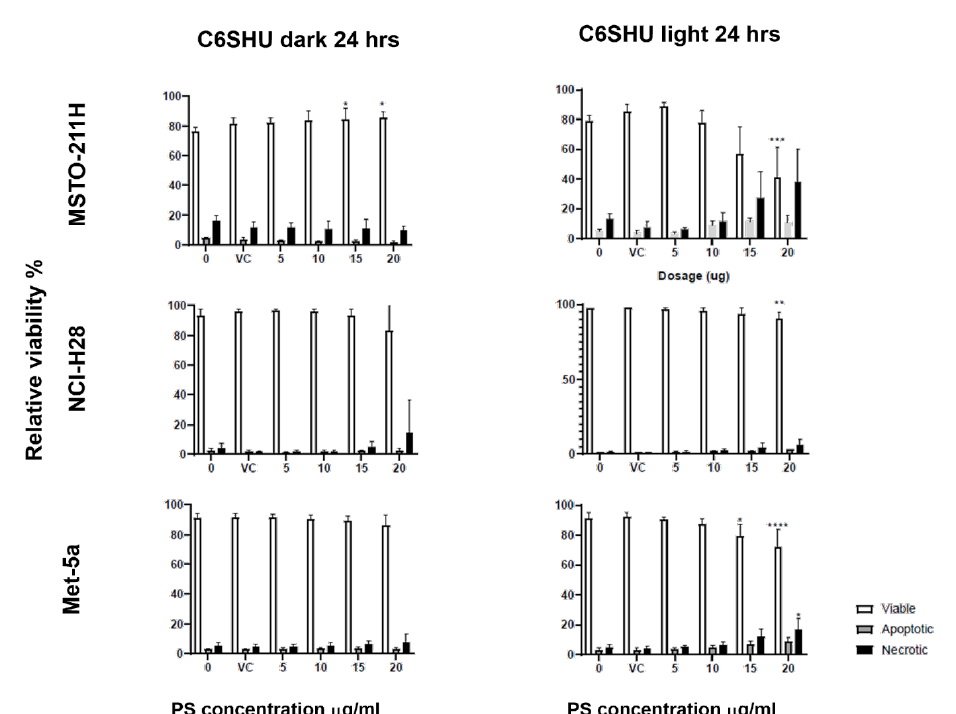
Figure 9. Cell death analysis of C6SHU-treated MSTO-211H, NCI-H28, and Met-5a cells as deter- mined by the Annexin V-FITC/PI assay 24 h after treatment. Results are expressed as the mean ± SD of three independent experiments. The varying significance of viable populations relative to that of the untreated control are indicated by * ( p ≤ 0.05), ** ( p ≤ 0.01), *** ( p ≤ 0.001), and **** ( p ≤ 0.0001).